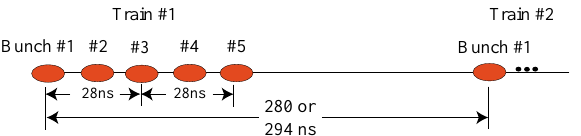
FIG. 1. (Color) There are nine trains of bunches in CESR. Each train is separated by 280 or 294 ns and can have up to five bunches per train. The spacing between bunches is 14